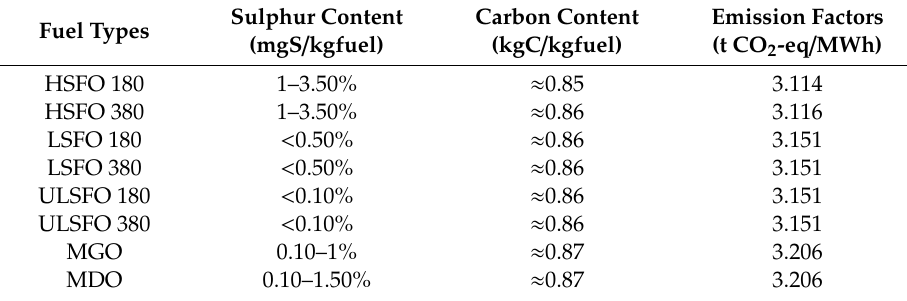
Table 1. Fuel types, specifications, emission factors